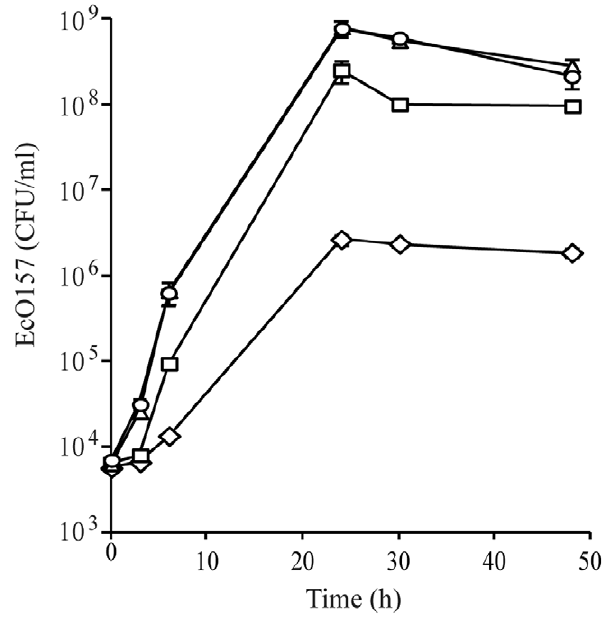
Figure 1 . Growth of EcO157 in spinach lysates. The concentration of EcO157 was determined in filter-sterilized 100% spinach lysates ( # ); non-sterile 100% spinach lysates ( D ); non-sterile 5% spinach lysates ( % ); and non-sterile 0.1% spinach lysates ( e ). Each datum point represents the mean bacterial concentration in three replicate cultures. Most bars representing standard deviation are too small to show.